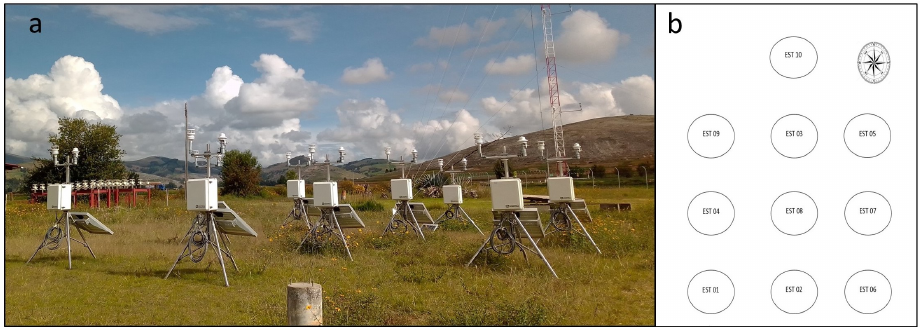
Figure 1. Distribution of the compact automatic stations in the site of study. ( a ) Picture of the installed compact automatic station in the Huancayo Observatory. ( b ) Distribution of the 10 stations, which have 3.5 m of the horizontal and vertical